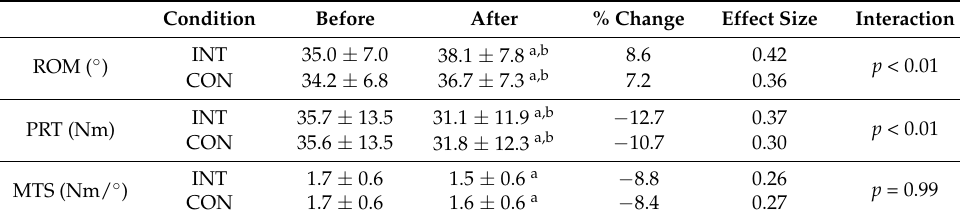
p < 0.01 p < 0.01 p = 0.99